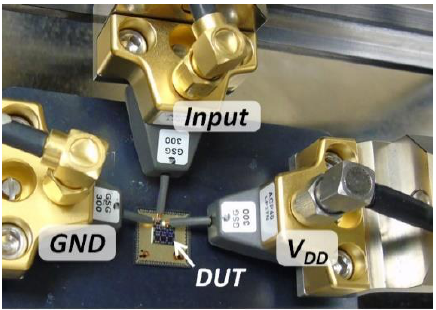
Figure 6. Photograph of the test chip and the RF probes setup used in the measurements [15].